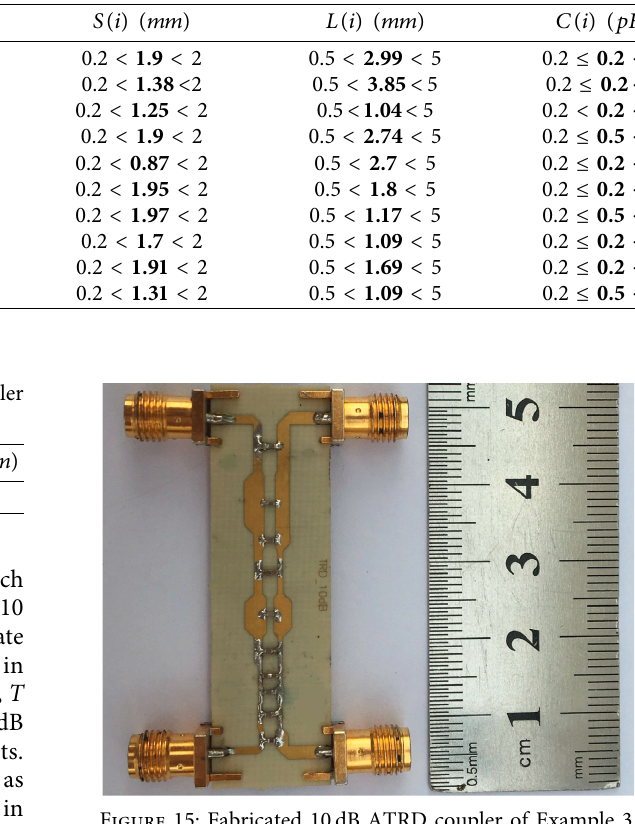
Table 9. Every loop of computer program optimization on